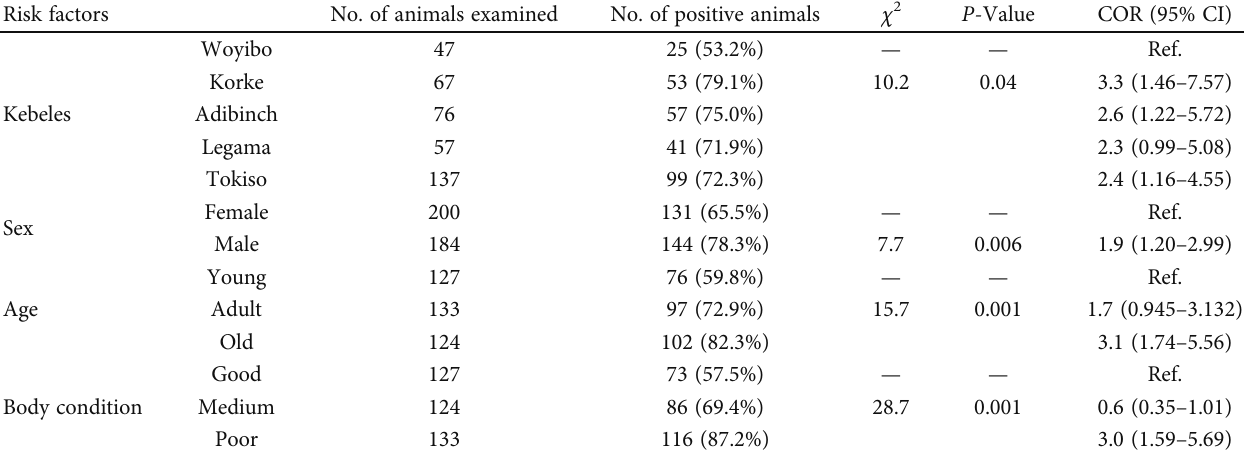
Table 1: Potential risk factors for ixodid ticks infestation status of cattle in the case of Areka District. Risk factors